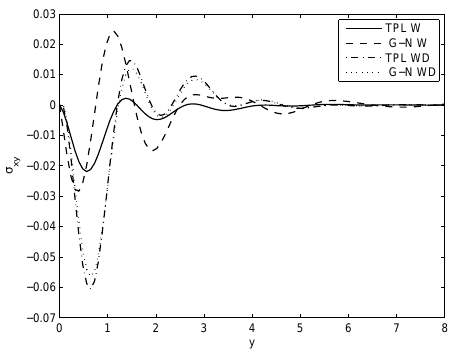
Fig. 4 Distribution the stress function σ xy with and without